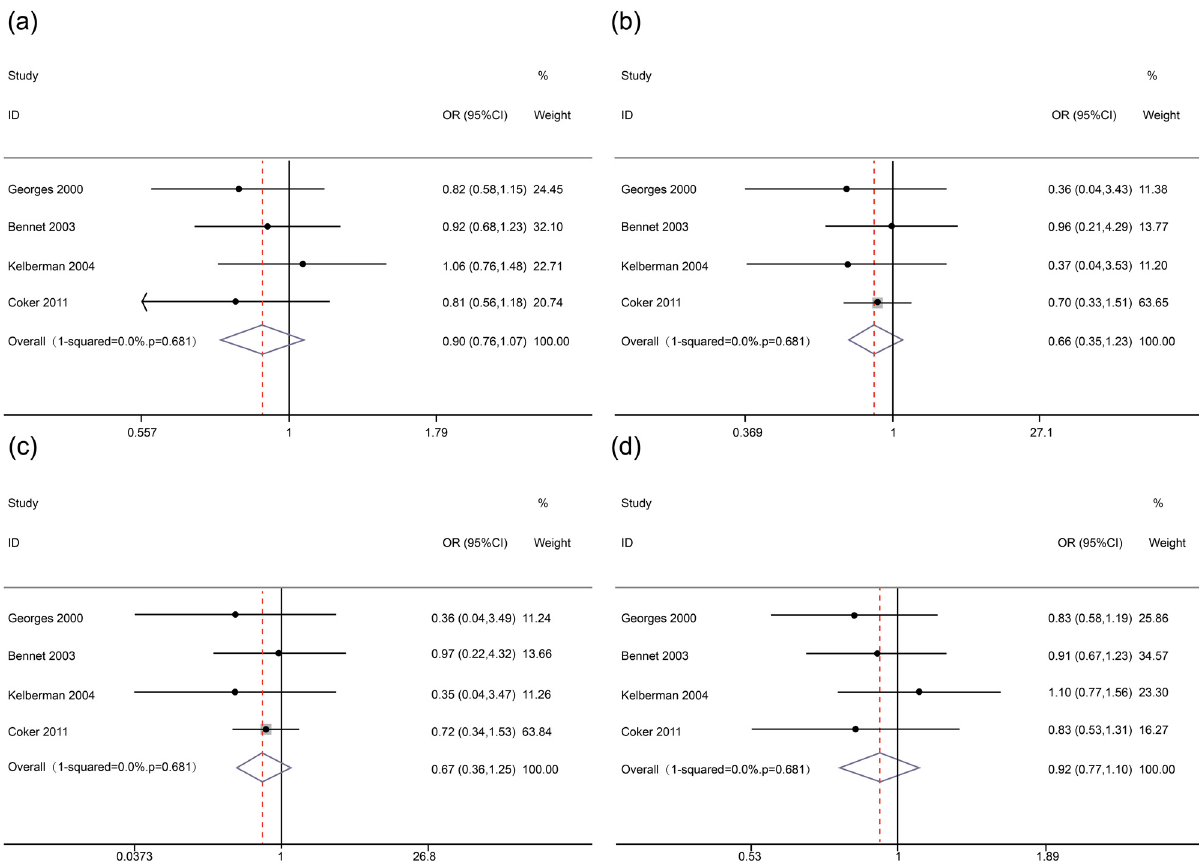
Figure 3: Forest plots for IL - 6 gene − 572 G > C polymorphism and MI in the subgroup analysis. ( a ) ( allelic model: C allele vs G allele ) , ( b ) ( additive model: C/C vs G/G ) , ( c ) ( recessive model: C/C vs G/C + G/G ) and ( d ) ( dominant model: C/C + G/C vs G/G )